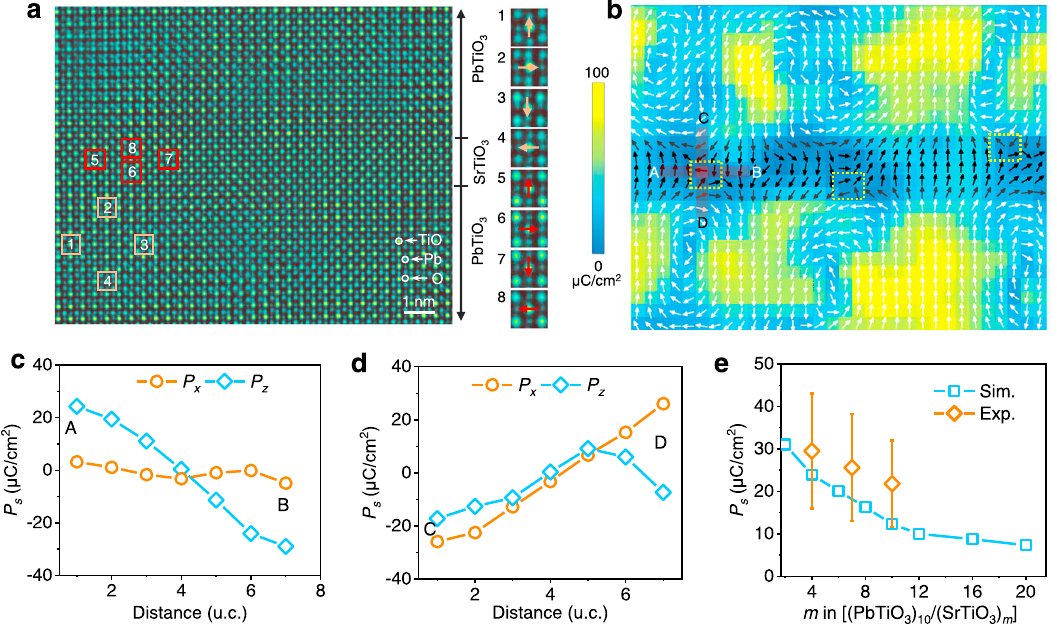
Fig. 3 Detailed polarization distribution of polar vortex – antivortex pairs in (PTO) 10 /(STO) 4 . a An atomically resolved iDPC image for 4-u.c. thick STO sandwiched between two 10-u.c. PTO layers, colored for clarity. From the enlarged views taken from the marked regions within PTO and STO, the atomic shift between cations and oxygen is visible with the naked eye. b The corresponding unit-cell scale map of polarization vectors, calculated from the atomic displacements between cations and oxygen. Arrows denote the polarization orientation and the color represents the magnitude. The yellow dotted boxes highlight the locations of antivortex cores. Variation of polarization along A – B ( c ) and C – D ( d ) directions, as marked in b . P x represents in-plane polarization and P z represents out-of-plane polarization. e The comparison of measured (orange) and phase- fi eld simulated (blue) average polarization versus m for (PTO) 10 /(STO) m . The error bar represents the standard